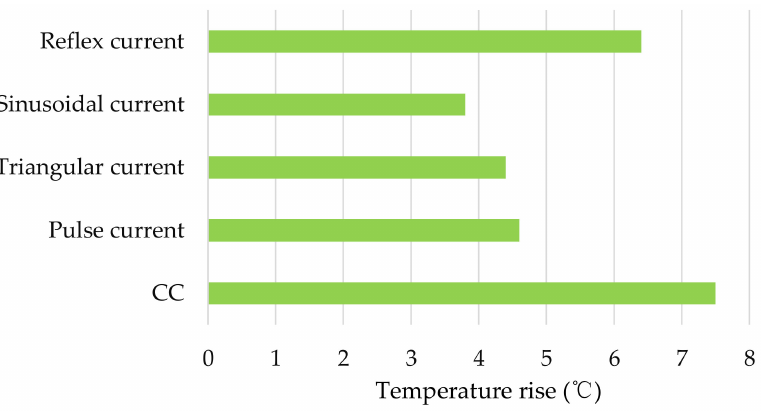
Figure 14. Charging-temperature increase comparison between five charging